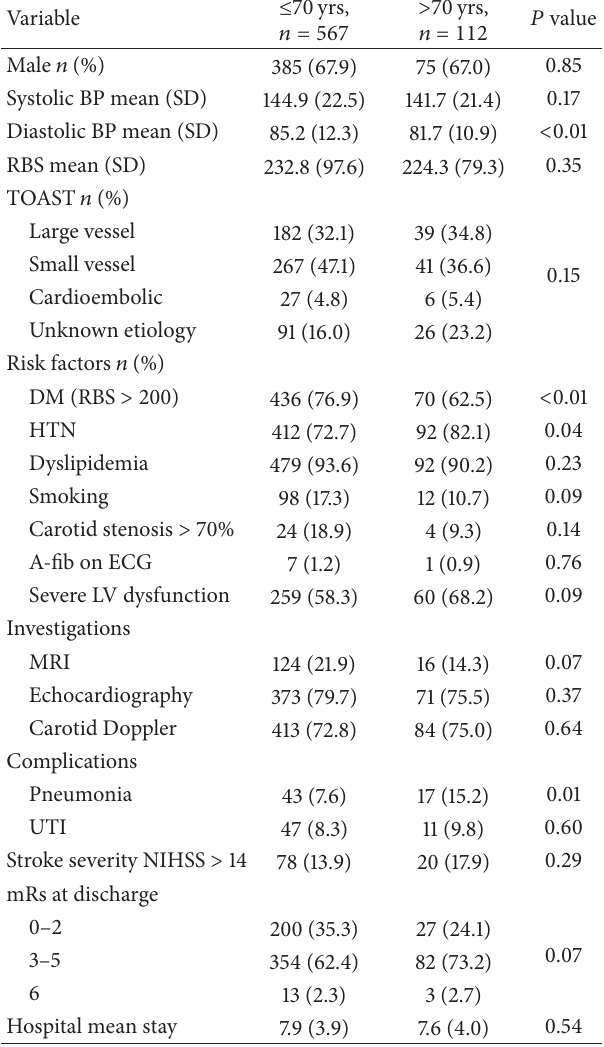
Table 5: Distribution of covariates among stroke patients in old